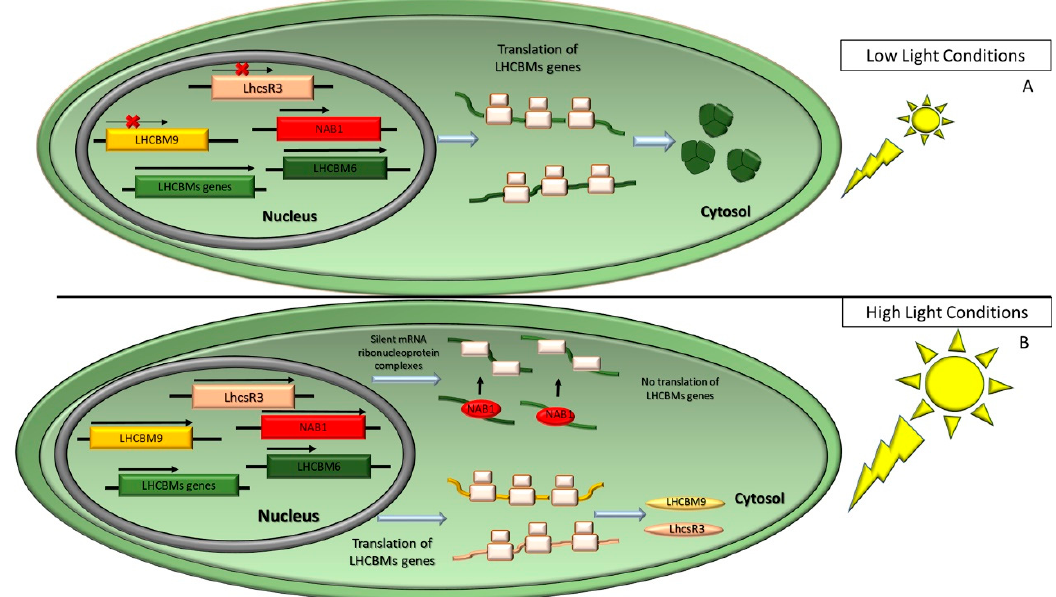
Figure 4. Scheme of long-term control mechanisms regulating light harvesting antenna size, as described in the model alga C. reinhardtii . ( A ) In low light conditions, carriers of the photosynthetic electron transport chain are oxidized, and all nuclear genes encoding LhcbMs isoforms associated to the PSII are expressed, except for the isoform 9. LhcbM-encoding mRNAs are translated in the cytosol, then targeted to the chloroplast and inserted in the thylakoid membranes. Under low light conditions, the translational repressor NAB1 is in a less active state. ( B ) In excess light conditions, ATP and NADPH produced by the light reactions exceed their consumption rate by the CBBc, and the overexcitation of PSII results in the release of reactive oxygen species (ROS). To alleviate excitation pressure, a remodelling of the antenna system is induced by slowing down the transcription of LhcbM genes. Once the translation of NAB1 is promoted, this subunit interacts with LhcbM-encoding mRNAs to form silent mRNA-ribonucleoprotein complexes. In contrast to all other isoforms, the expression of LhcbM9 and LhcsR3 proteins are induced.